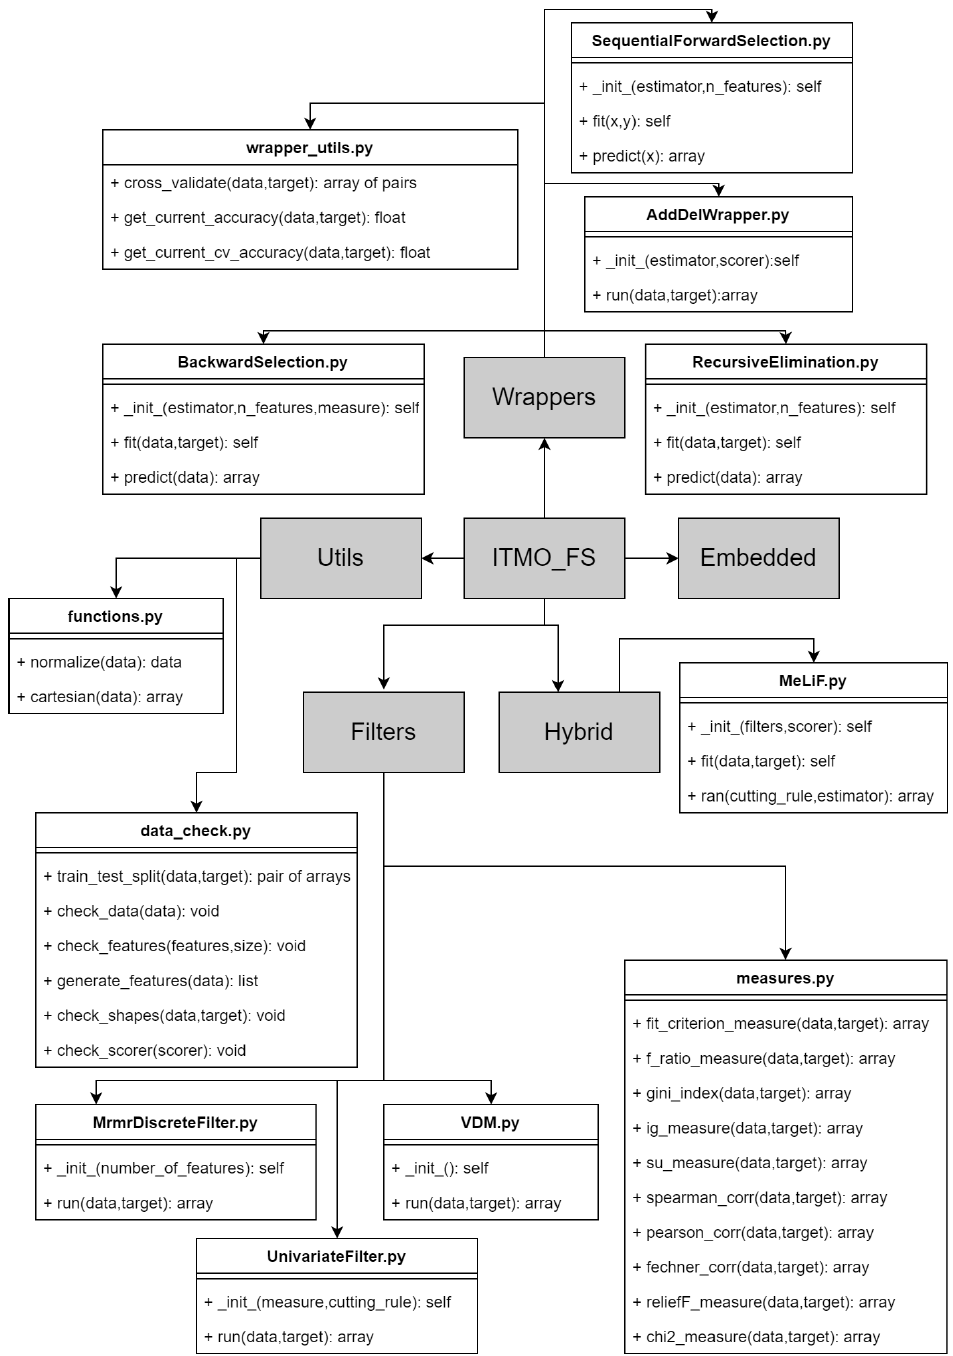
Figure 1. ITMO FS library